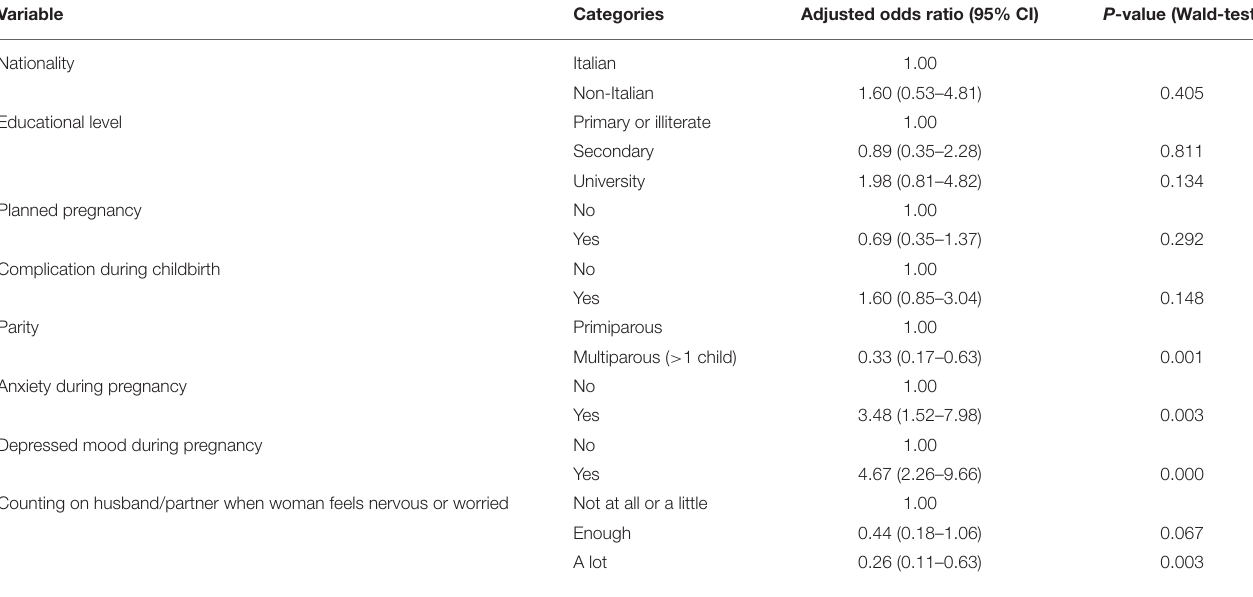
TABLE 2 | Risk factors associated with current symptoms of postnatal anxiety as assessed with STAI ( ≥ 40): results of multiple logistic regression analysis.